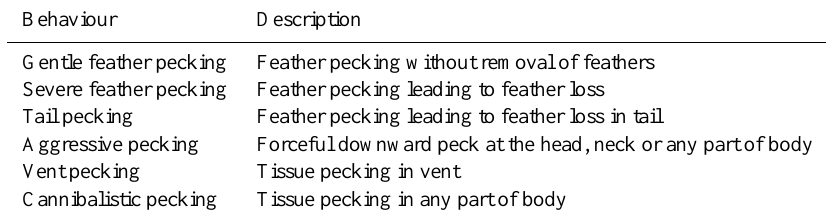
Table 2. Flock prevalence (FP) 1 and total feather scores (TFS) 2 in control and treatment groups.